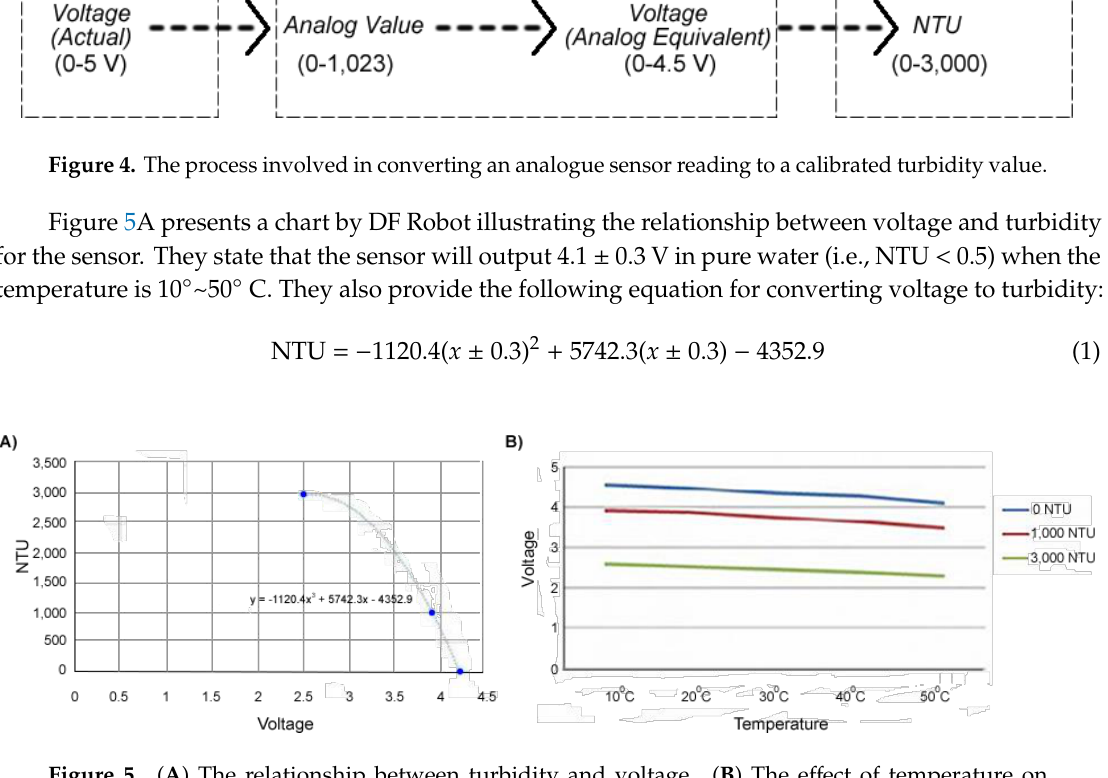
Figure 4. The process involved in converting an analogue sensor reading to a calibrated turbidity